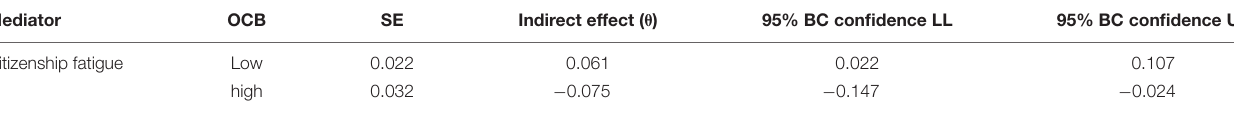
TABLE 3 | The mediating effect of citizenship fatigue on the relationship between OCB and CWB. Mediator